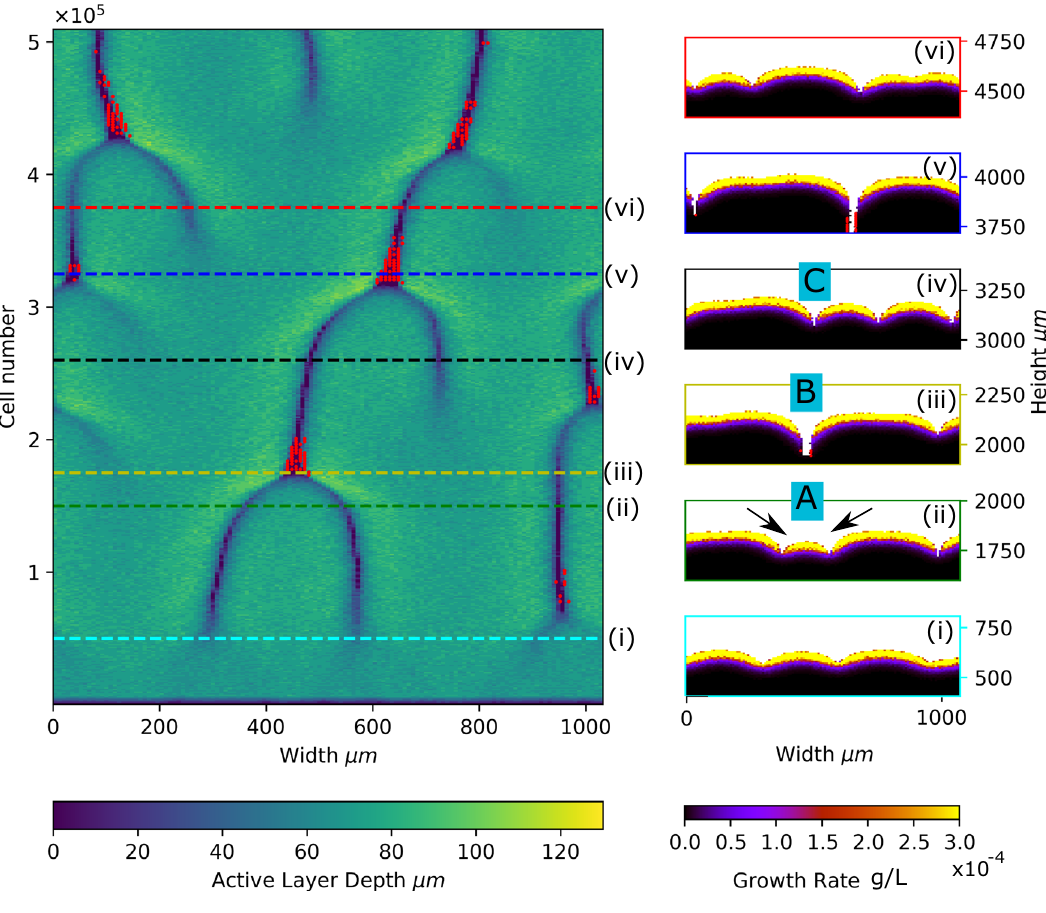
Fig. 6 Active layer gap dynamics and pinning. The left panel shows an active layer kymograph plot for a simulation in the transiently pinned phase ( S bulk = 0.005 g/L, μ max = 0.2 1/h). The local active layer thickness is plotted along the bio fi lm width (horizontal axis). Active layer thickness is indicated by the colour scale, such that darker colours represent regions with thin or no active layer and lighter colours represent regions with a thicker active layer. The vertical axis represents the number of bacterial cells in the bio fi lm (i.e. the total biomass), revealing the dynamics of the active layer as bio fi lm growth progresses. In the kymograph, gaps in the active layer are visible as dark lines. The red dots indicate local regions of the interface that are pinned (see Methods). Snapshots (i – vi) on the right-hand side correspond to the dashed lines on the kymograph. Labels A, B and C indicate regions of the interface corresponding to just before, during and after the formation of a pinning site. In particular, a small bulge in the interface (labelled A), bordered by two active layer gaps (arrows) is engulfed by the lateral expansion of surrounding, larger bulges (B and